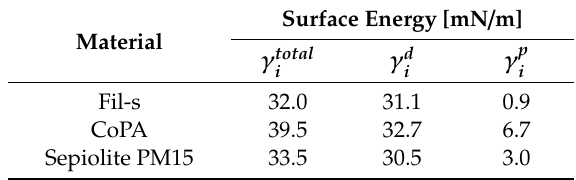
Table 4. Surface energy data of the ternary system components.